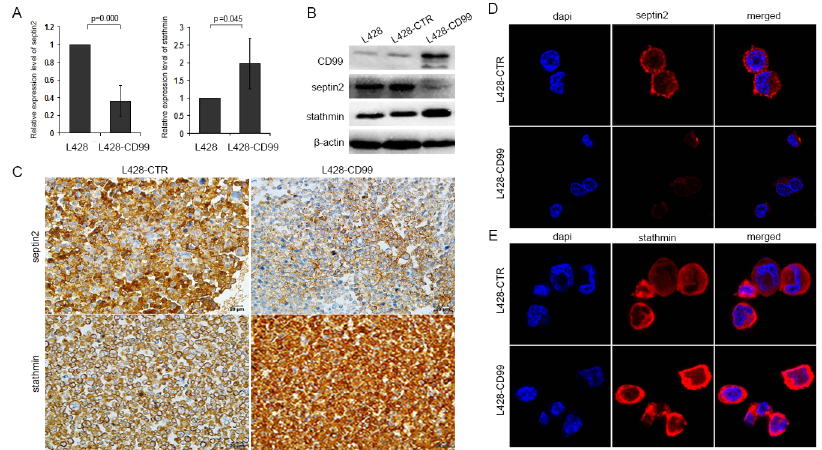
microscopy (D, E) (original magnification ×400).